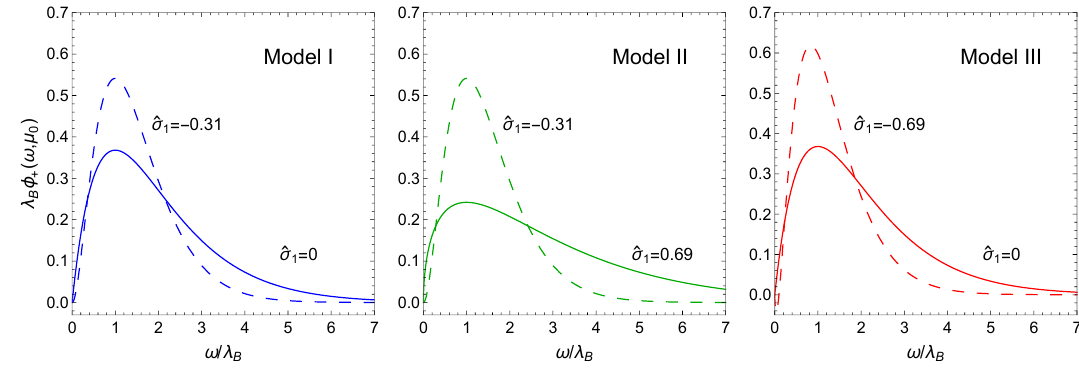
Figure 3 . B -meson leading-twist LCDA (cid:21) B (cid:30) + ( !; (cid:22) 0 ) for the three models described in the text. with ^ (cid:27) = 1 de(cid:12)ning (cid:21) . To the NLL accuracy only the values of (cid:21) 0 B